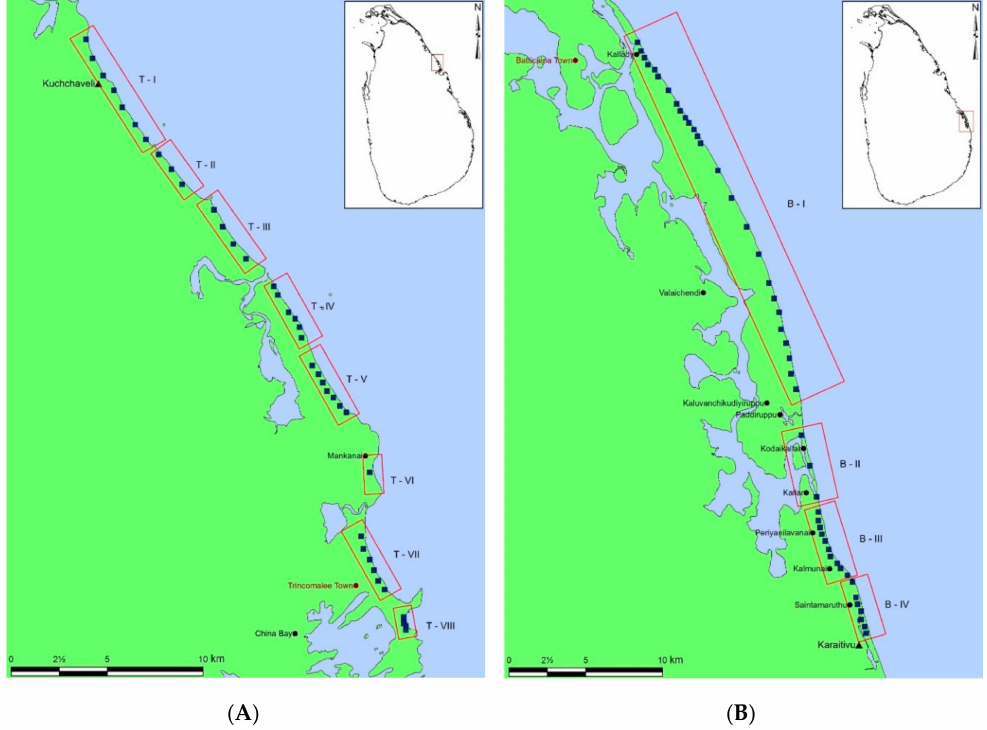
Figure 2. Location of measured beach profiles and adopted zonation in ( A ) Trincomalee and ( B ) Batticaloa.